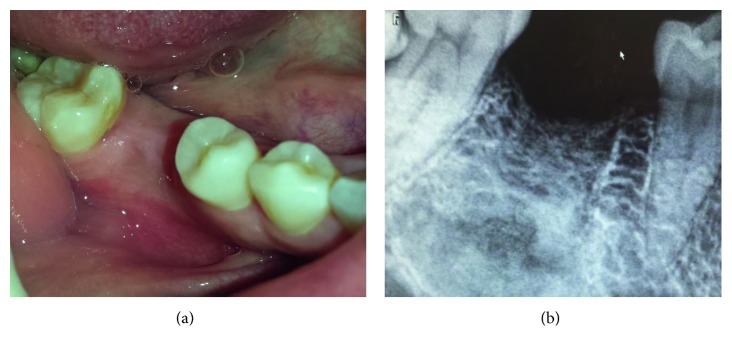
Clinical and radiological control at the 6 month with good mucosal and bone healing.